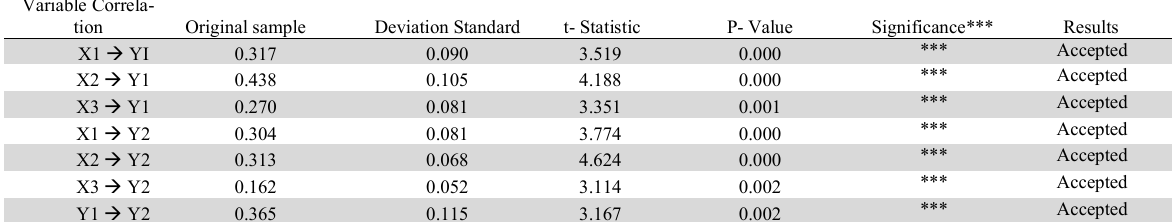
Path Coefficient or Direct Variable Influence